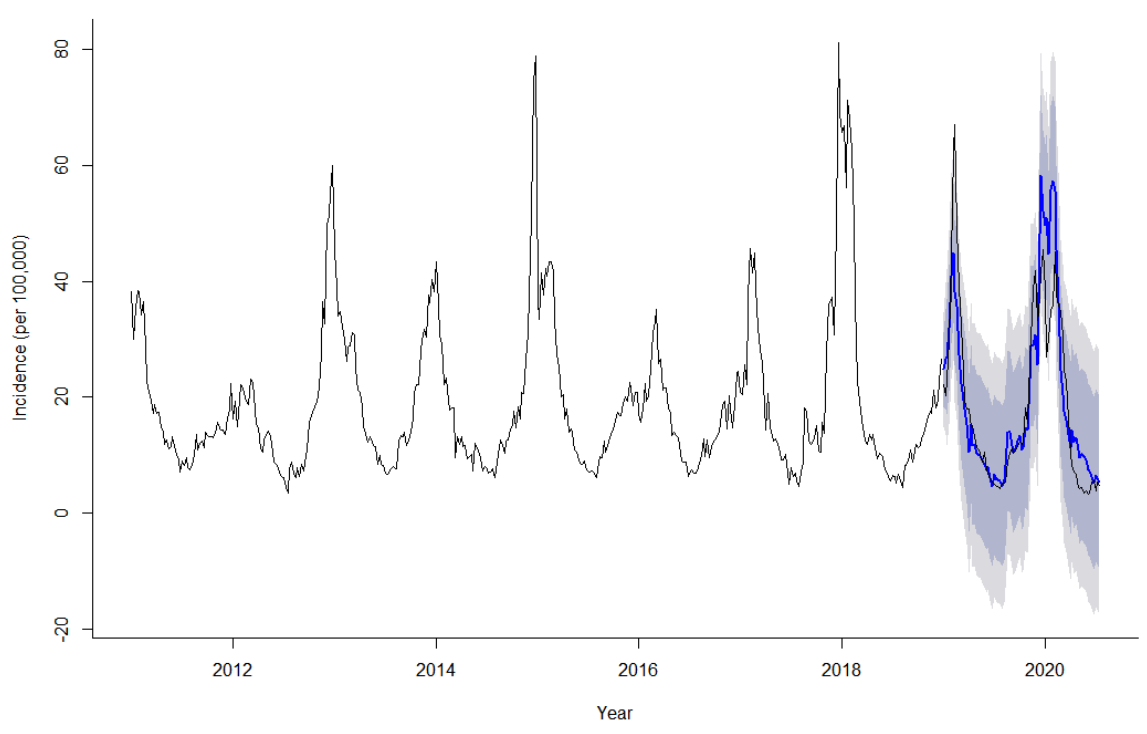
Figure 6. Comparison of actual and predicted incidence of ILI in the United States. Table 4. Predictive value of ILI incidence (per 100,000).